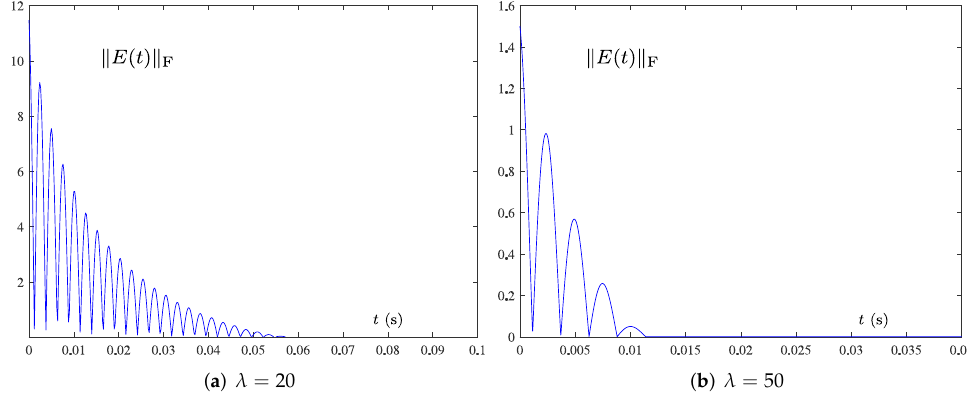
Figure 10. Simulation results under the aperiodic multiple-harmonic noise, PTCAZNN model (39) for TVMIP of (40) with λ = 20,50, respectively. Table 3. Convergence time of the OAZNN model and PTCAZNN model using the same